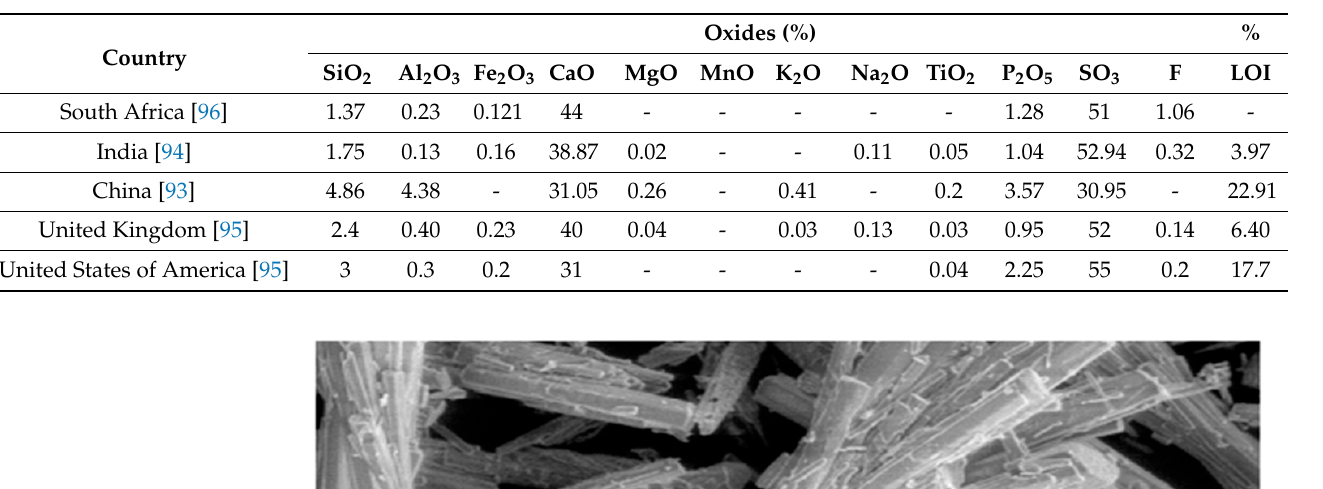
Table 3. Chemical composition of phosphogypsum in different areas of the world.